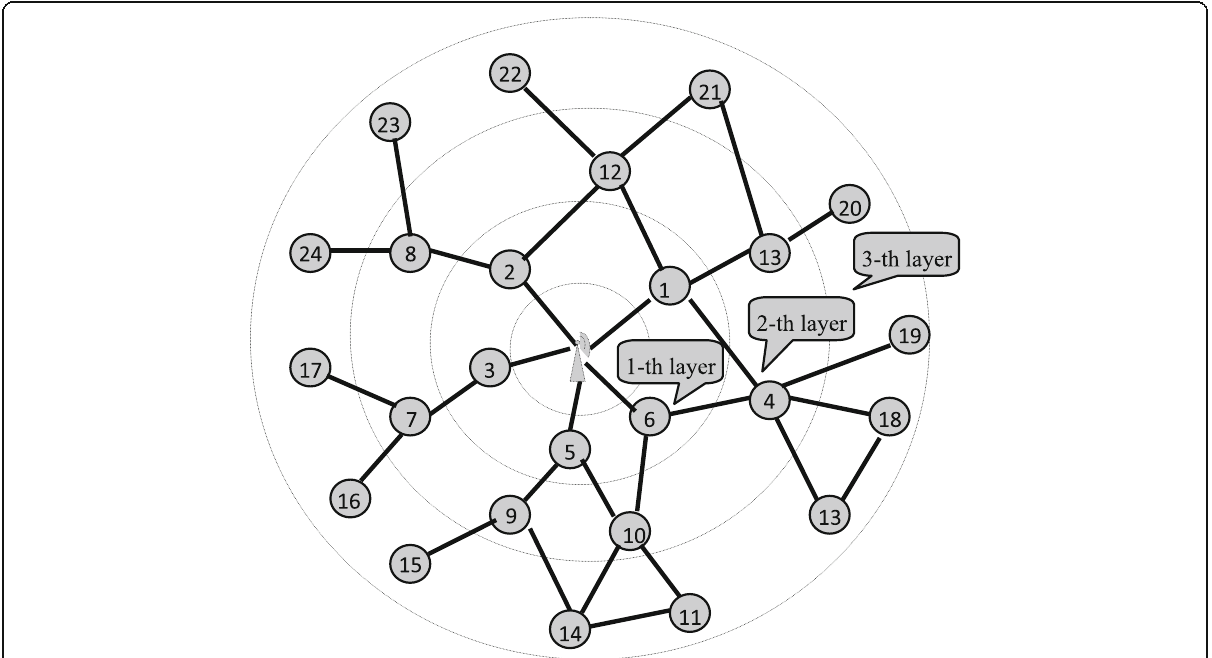
Fig. 1 Schematic diagram of network structure. An example of a network model, where 1 – 24 represent the nodes, the center is the sink node, and the dotted circles represent the network layers from the inner to the outer for the first to the third